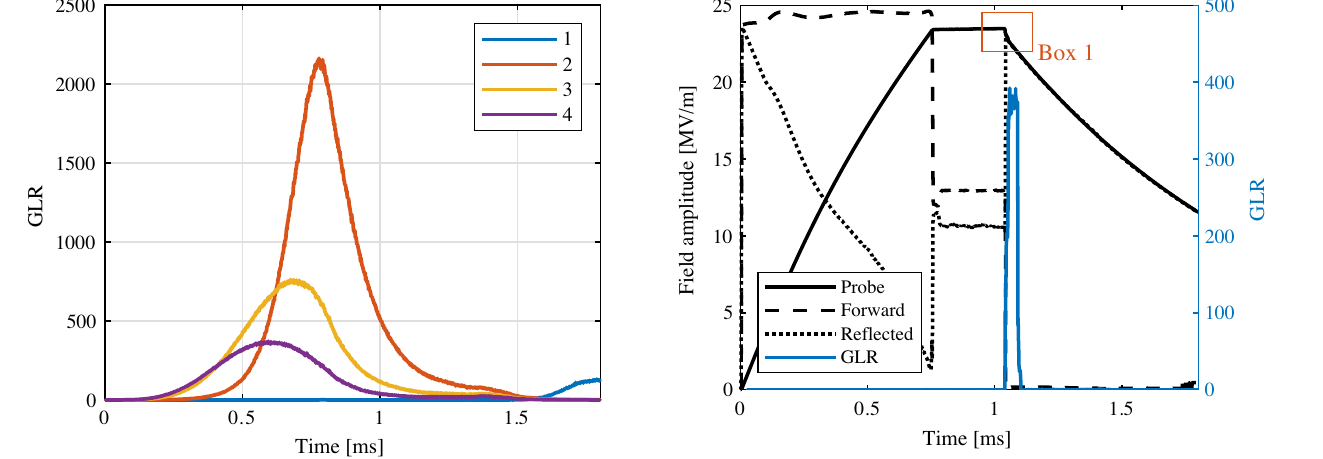
FIG. 8. Field emitter signals for cavity C1.M3, for the same pulse as in Fig. 7.